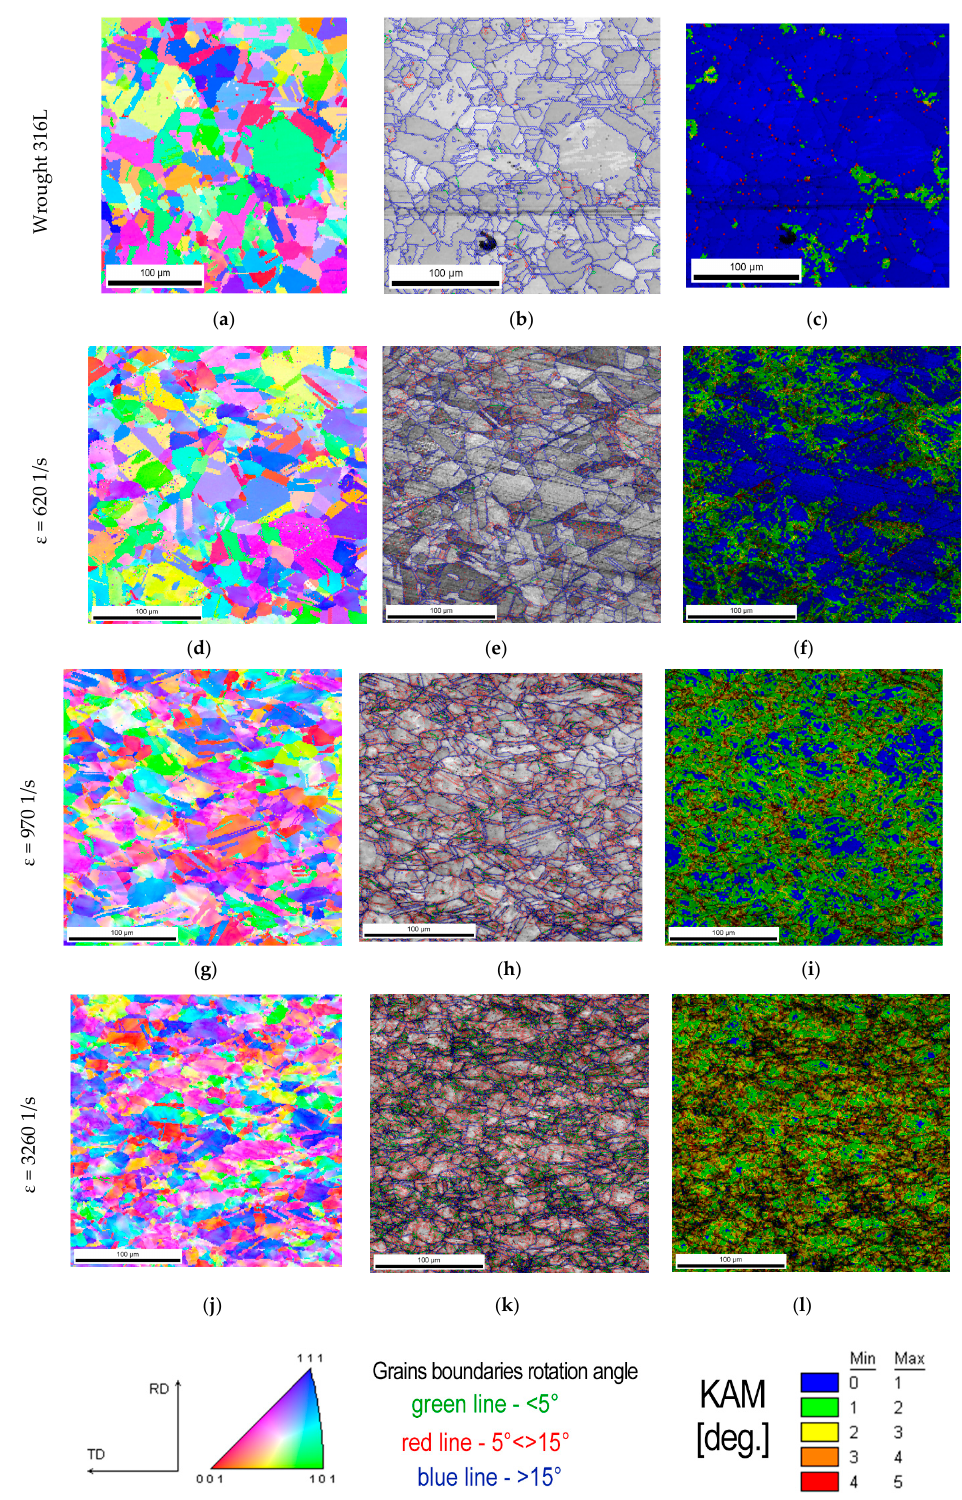
Figure 10. Comparison of the impact of dynamic plastic deformation on the microstructure of an implant made of 316L and subjected to dynamic plastic deformation at various rates: ( a – c ) not deformed; ( d – f ) 𝜀(cid:4662) = 620 s − 1 ; ( g – i ) 𝜀(cid:4662) = 970 s − 1 ; ( j – l ) 𝜀(cid:4662) = 3260 s − 1 . The microstructure illustrated with the